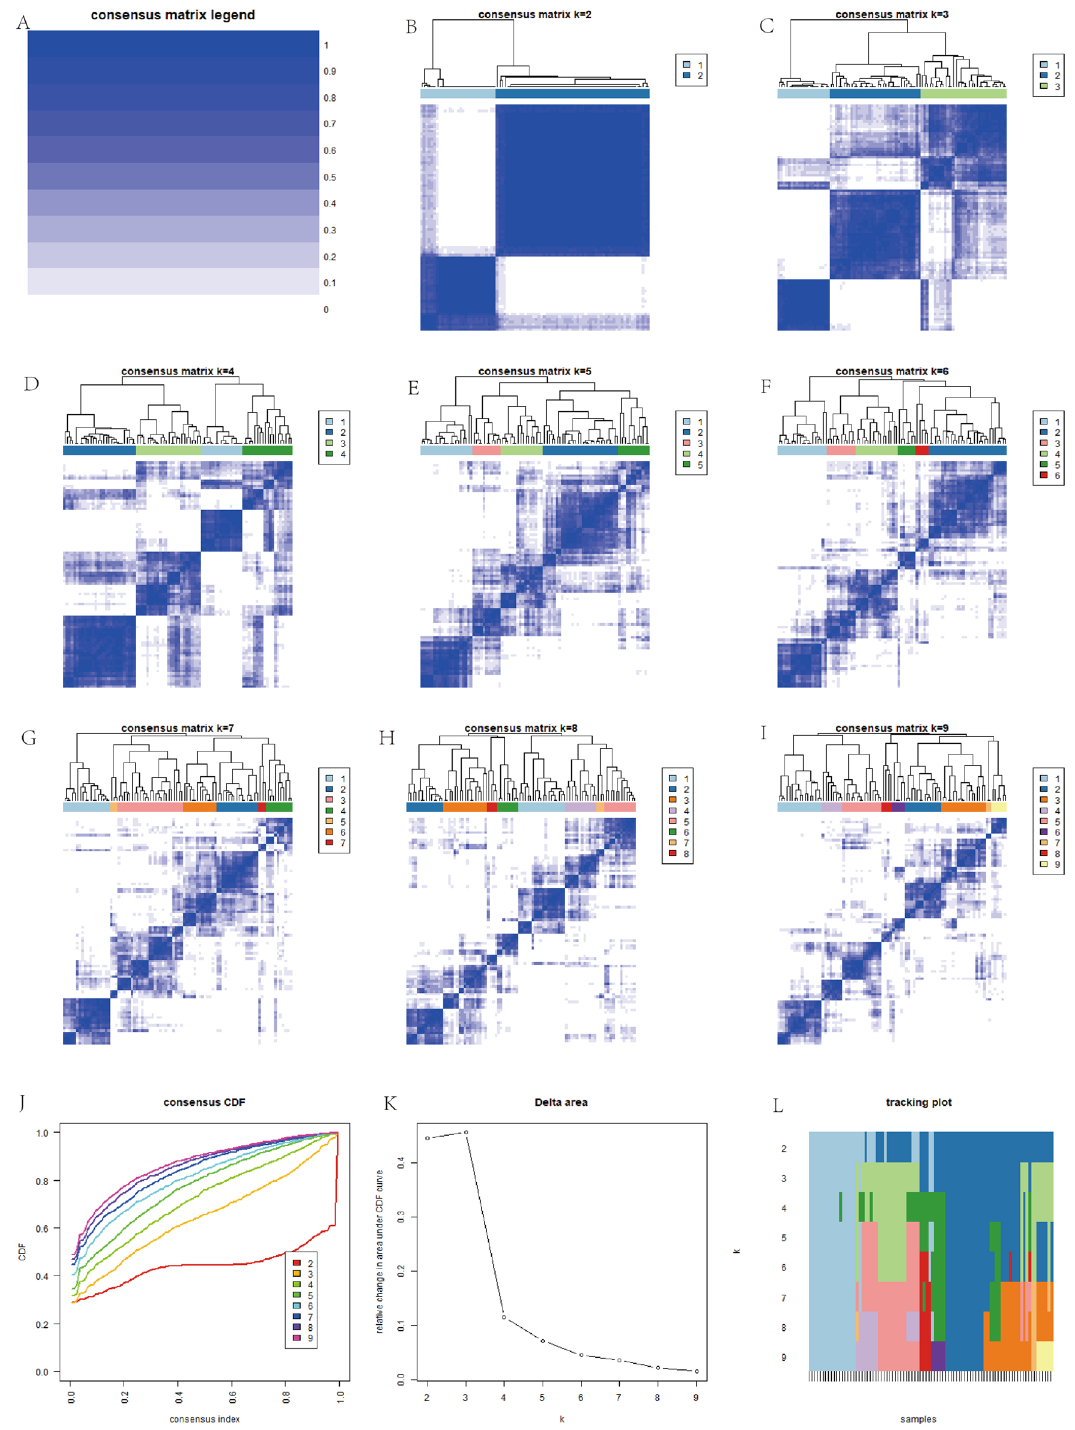
Figure 4. M6A-associated gene tumor typing map. ( A – L ) Indicates that we simulated the classification of tumors into 1–9 different grouping scenarios based on the expression of m6A-related